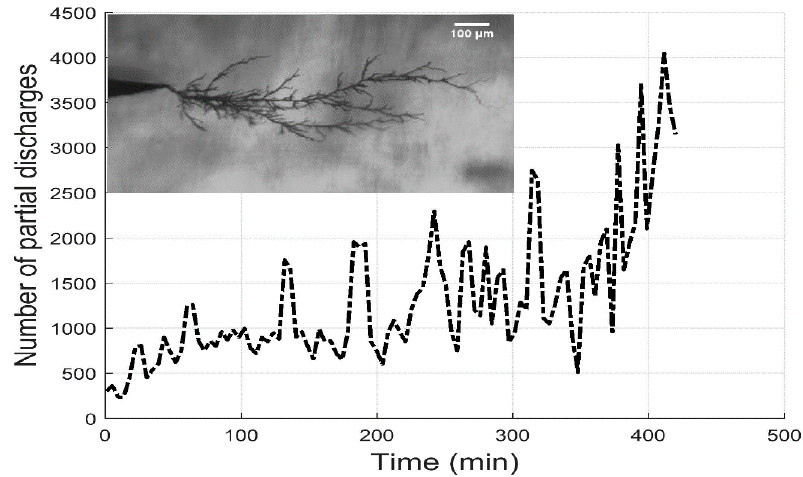
Figure 12. Partial discharge activities of ET growth under polarity reversal for case (I) in Table 4.